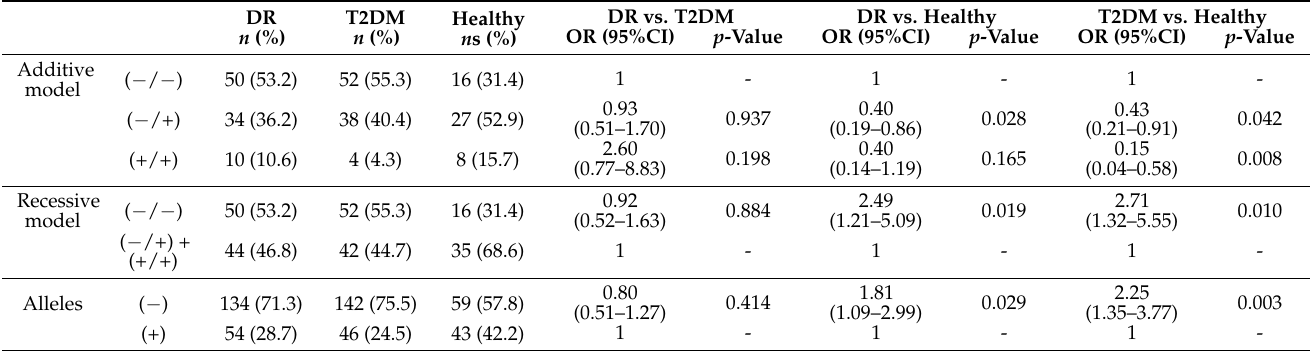
Table 3. Association analysis of the BglII polymorphism in ITGA2